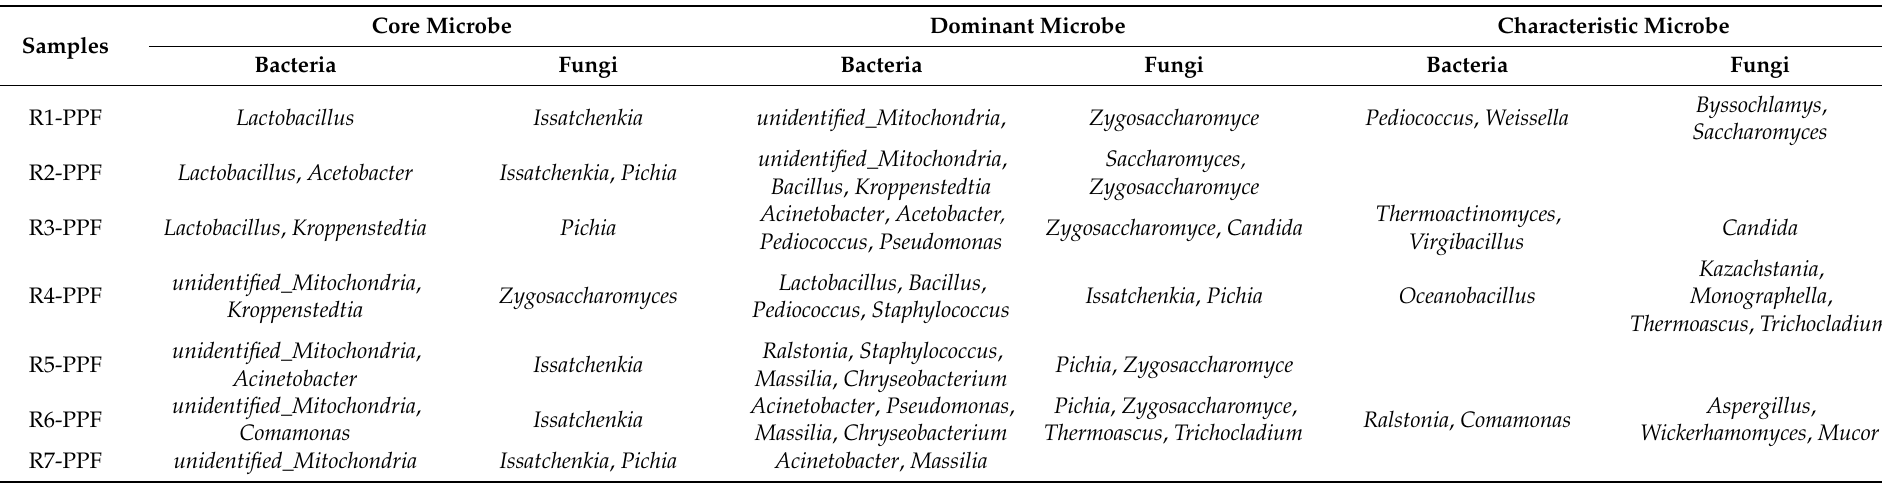
Table 3. Core microbe, dominant microbe, and characteristic microbe during different rounds of pre-pit fermentation